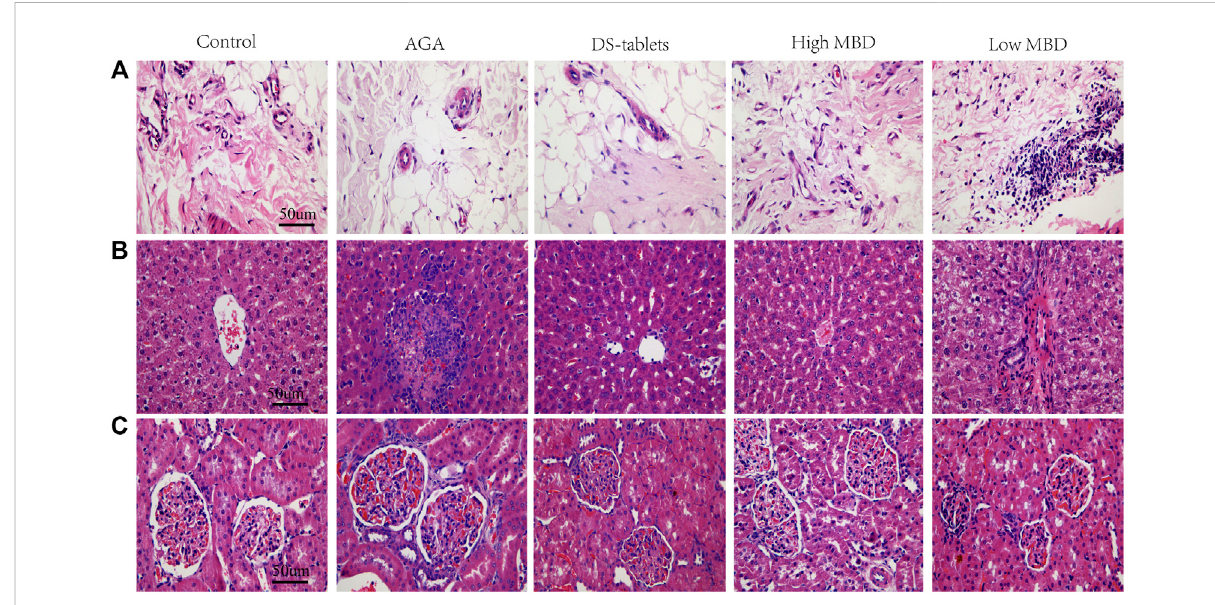
FIGURE 3 PathologicaleffectsofMBDonsodiumurate-inducedsynovialtissueandliverandkidney. (A) Synovialtissue. (B) Liver. (C) Kidney.Positivephase contrast microscope, magni fi cation